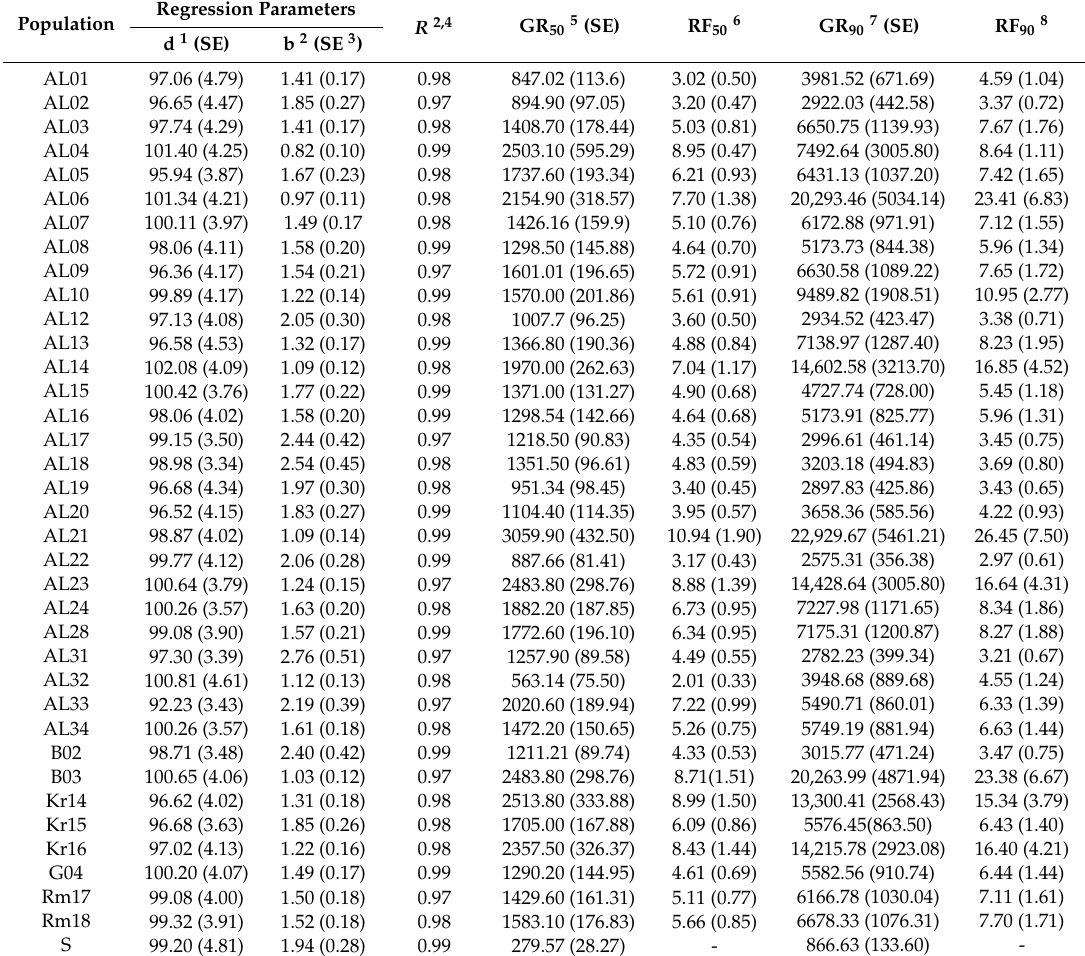
Table 4. Estimated non-linear regression parameters for the P. brachystachys populations in response to DM, based on the dry